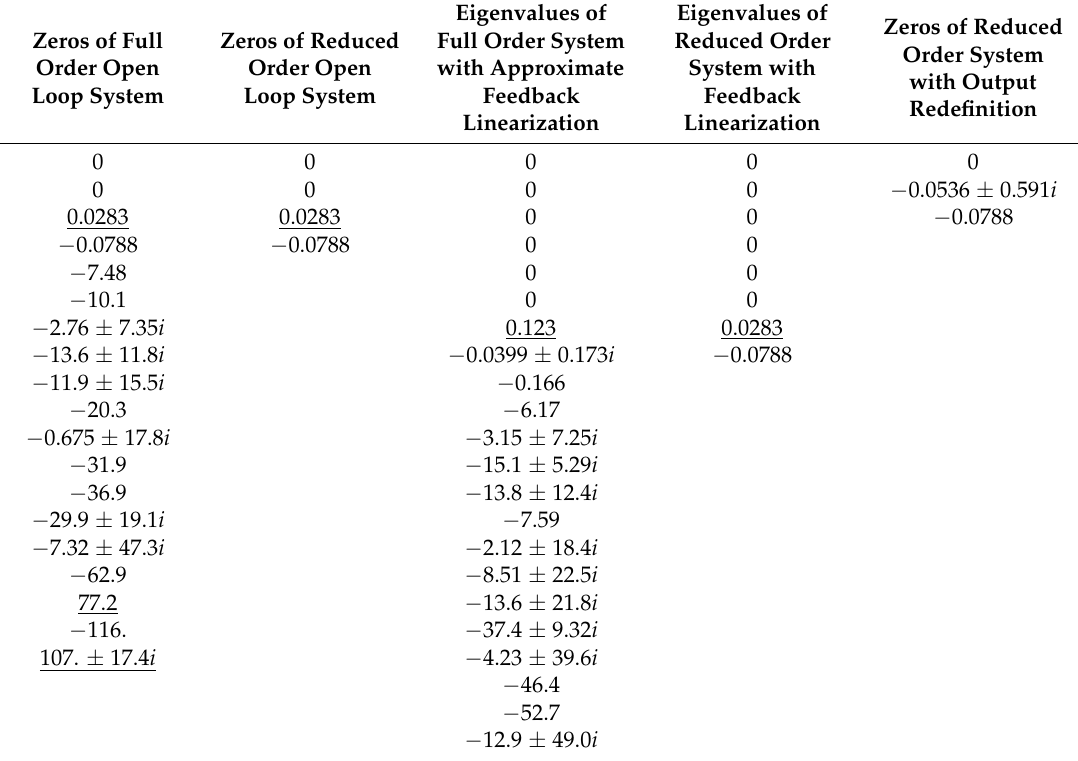
Table 3. Summary of transmission zeros at 80 kts forward flight, full and reduced order models, and along with eigenvalues of with feedback linearization loop closed. The underlined values indicate NMP zeros and corresponding unstable eigenvalues in the closed loop